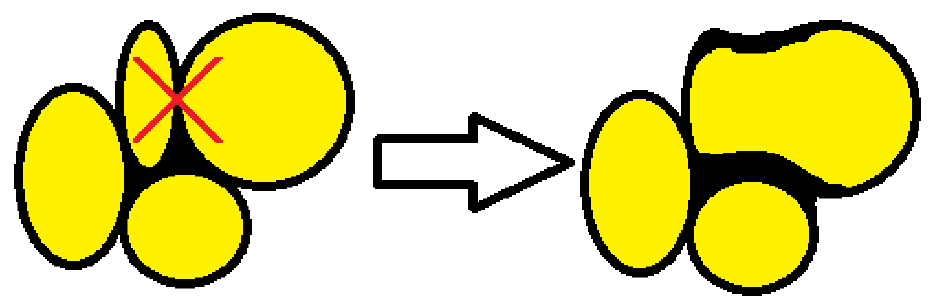
Figure 8. Bubble merging tendency.